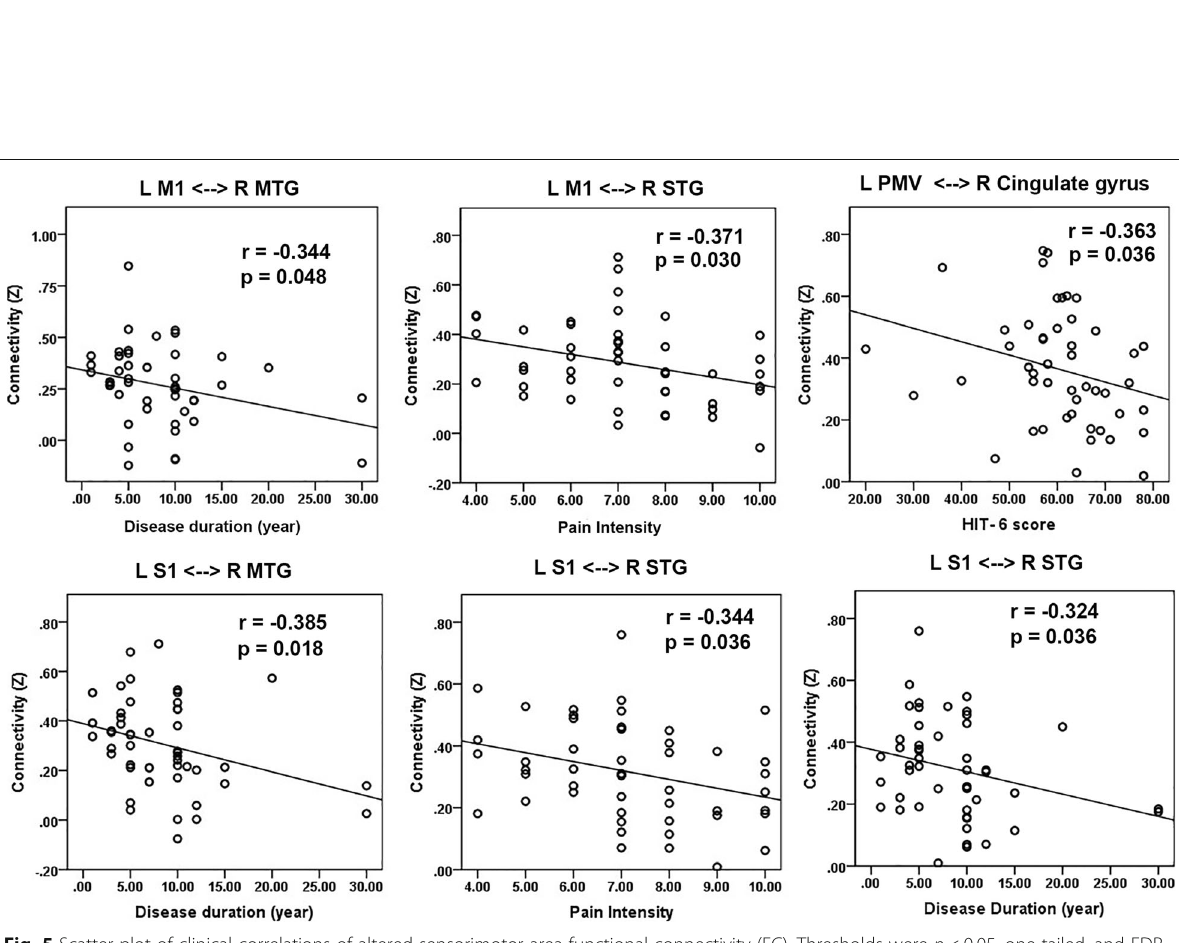
Fig. 5 Scatter plot of clinical correlations of altered sensorimotor area functional connectivity (FC). Thresholds were p < 0.05, one-tailed, and FDR corrected for multiple